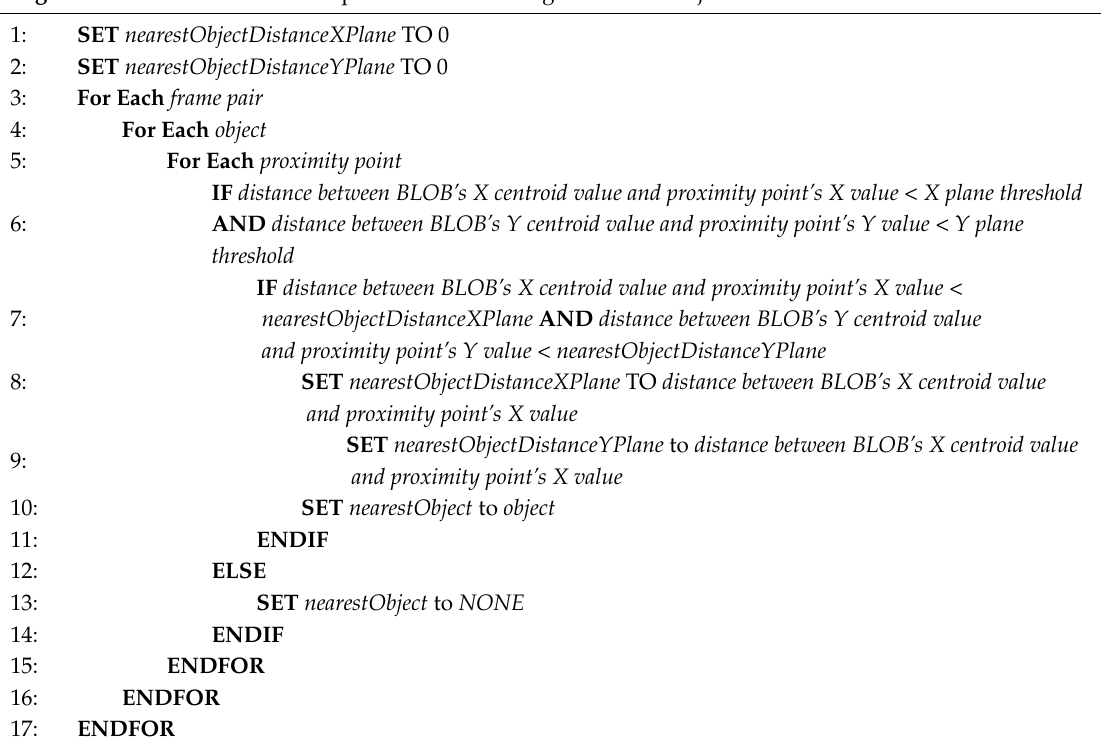
Algorithm 1 Pseudo code for the process of calculating the nearest